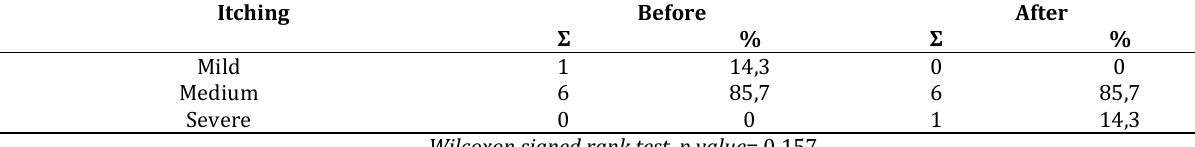
Table 1. Cross-tabulation between the itching before and after being given the virgin olive oil in the control group